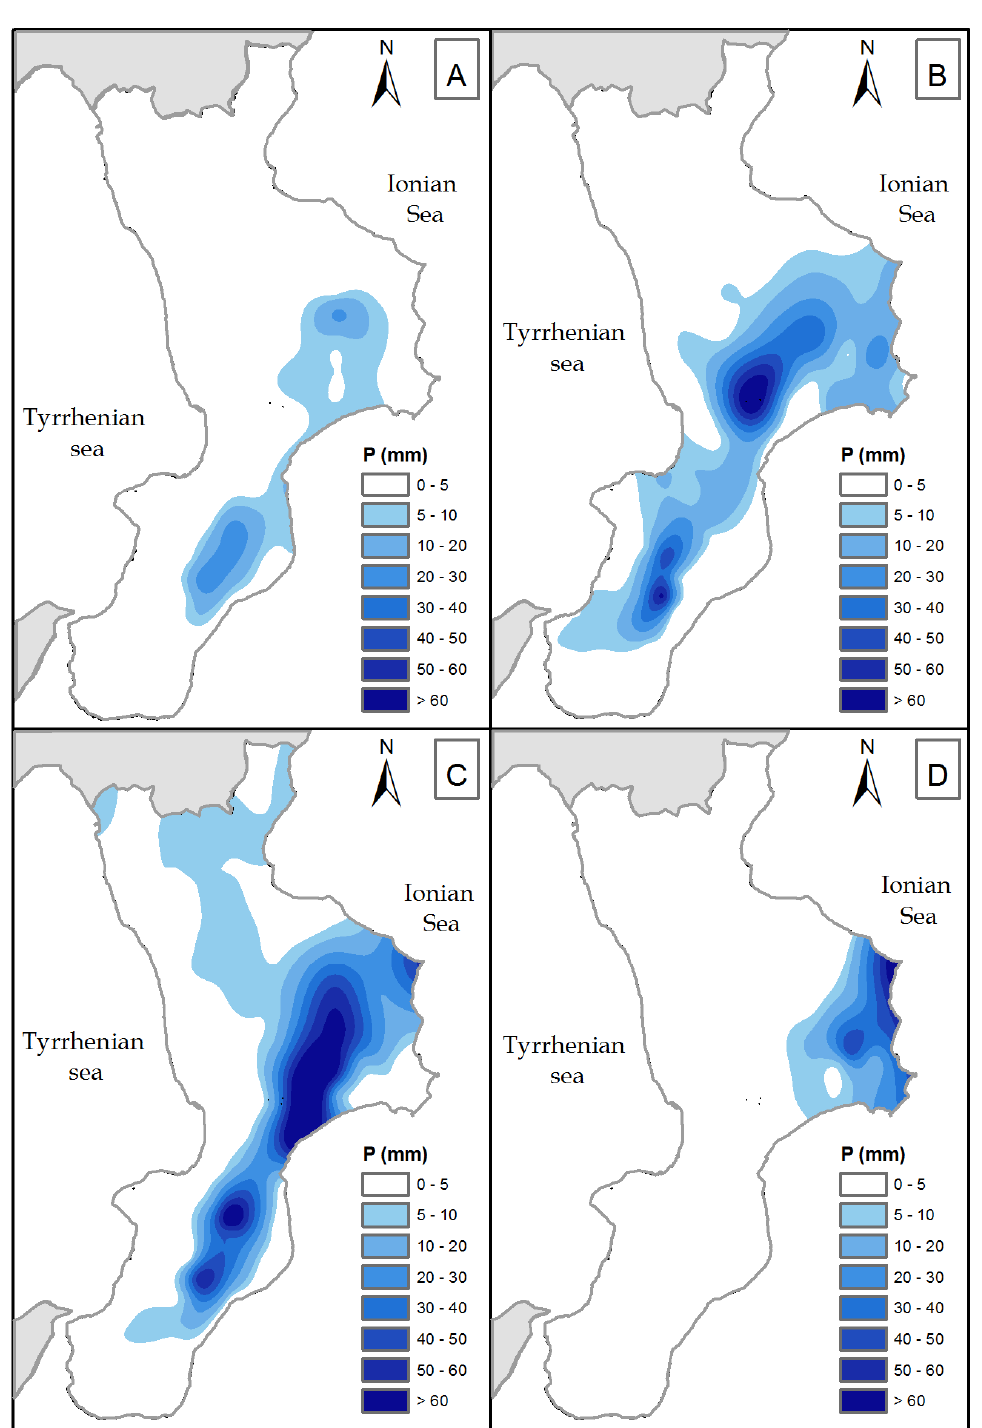
Figure 3. Hourly rainfall registered on 19 November 2013. ( A ) 0:00–3:00